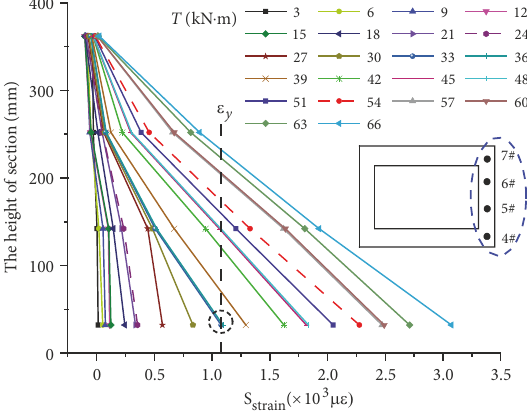
Figure 7. Location-strain curves of mid-span cross